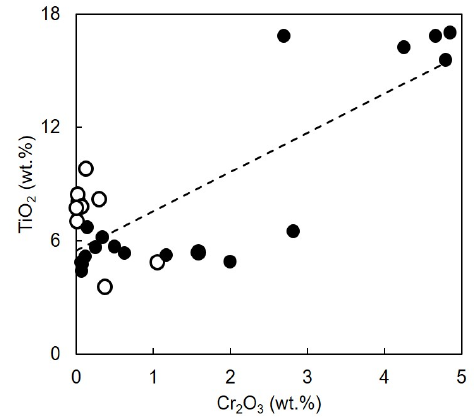
Figure 7. Plot of TiO 2 vs. Cr 2 O 3 for Ti-magnetite in the Dokdo and Ulleung volcanic rocks; symbols are as in Figure 4.